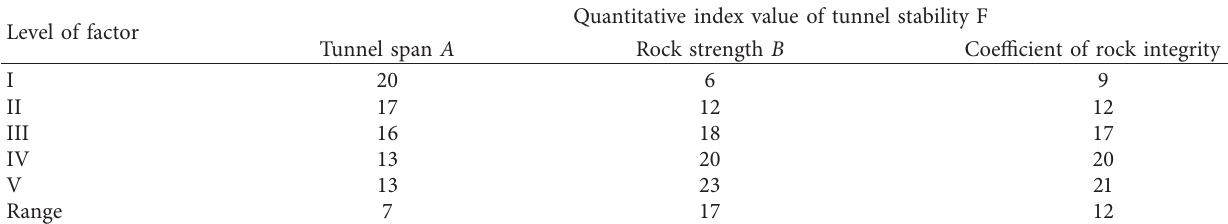
Table 8: Quantitative index value of tunnel stability under different factor